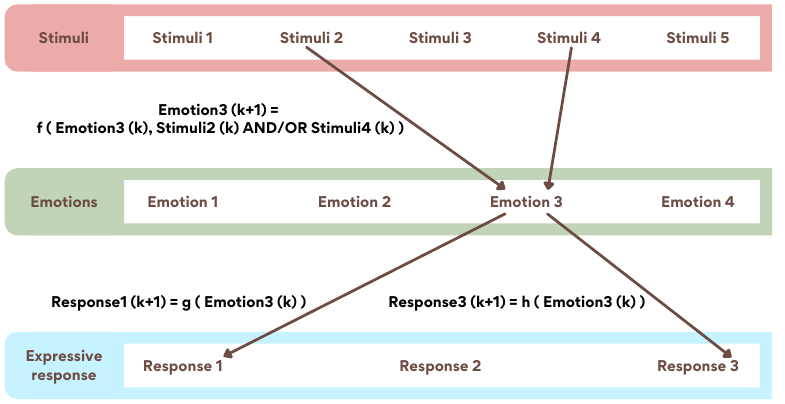
Figure 5. Connection between stimuli, emotions, and